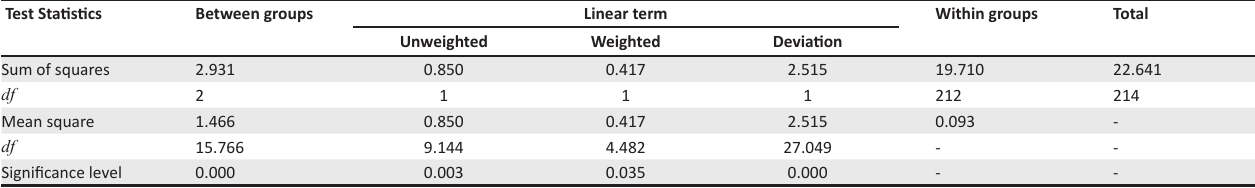
TABLE 5: ANOVA test for type of enterprise in the DEPZ. Test Statistics Between